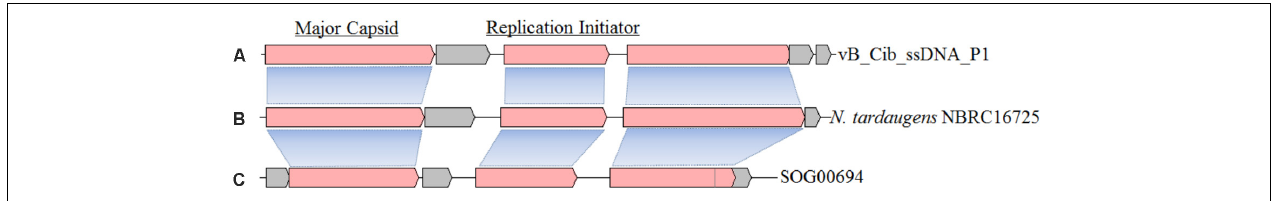
FIGURE 2 | The structure and gene compositions of phage vB_Cib_ssDNA_P1 (A) and two other close relatives, including a prophage found in Novosphingobium tardaugens NBRC 16725 (accession no. BASZ01000013) (B) and the environmental ssDNA viral sequence SOG00694 (accession no. JX904102) (C) .